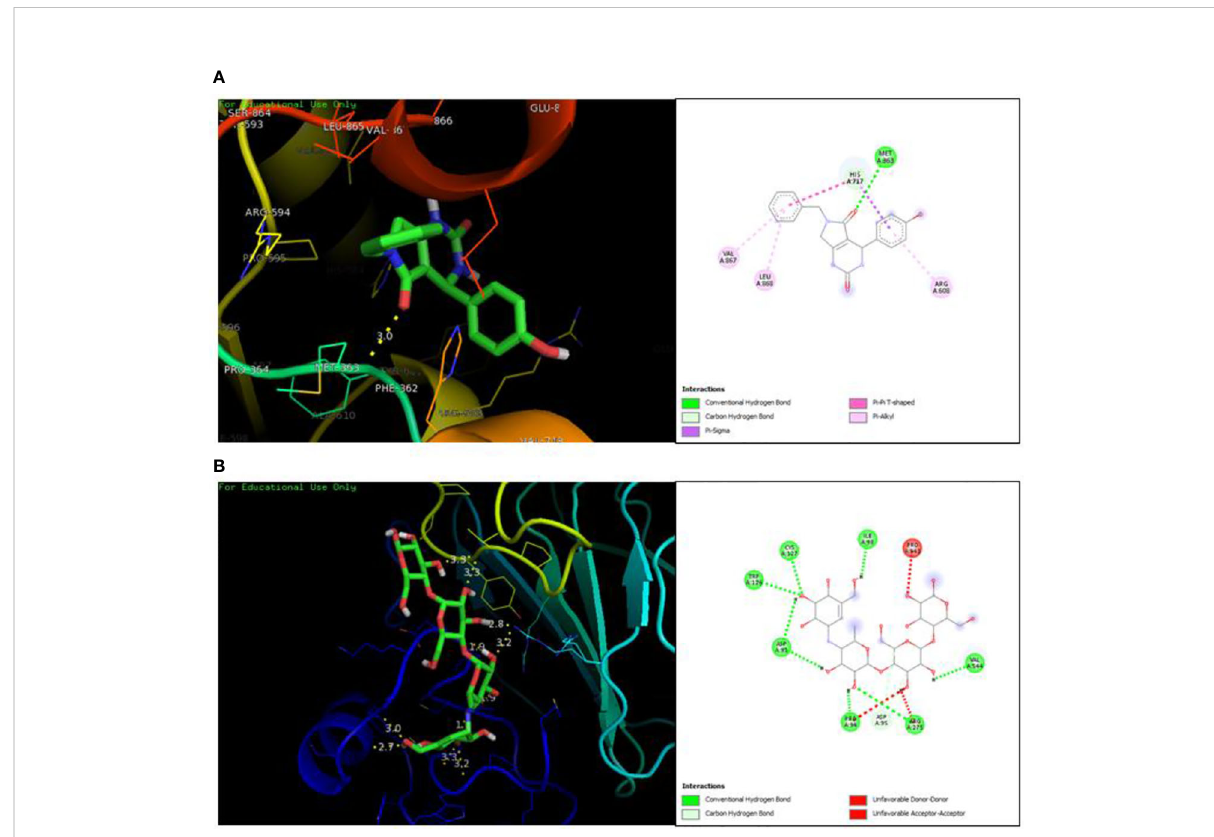
FIGURE 2 Protein-ligand interaction showing compound A (A) and standard acarbose (B) in the active binding site of protein a